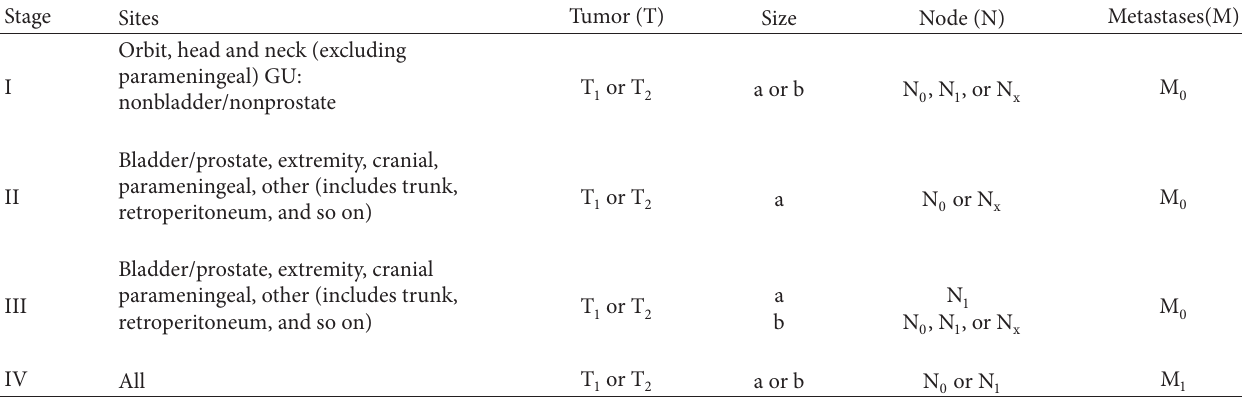
Table 1: IRSG Presurgical Staging